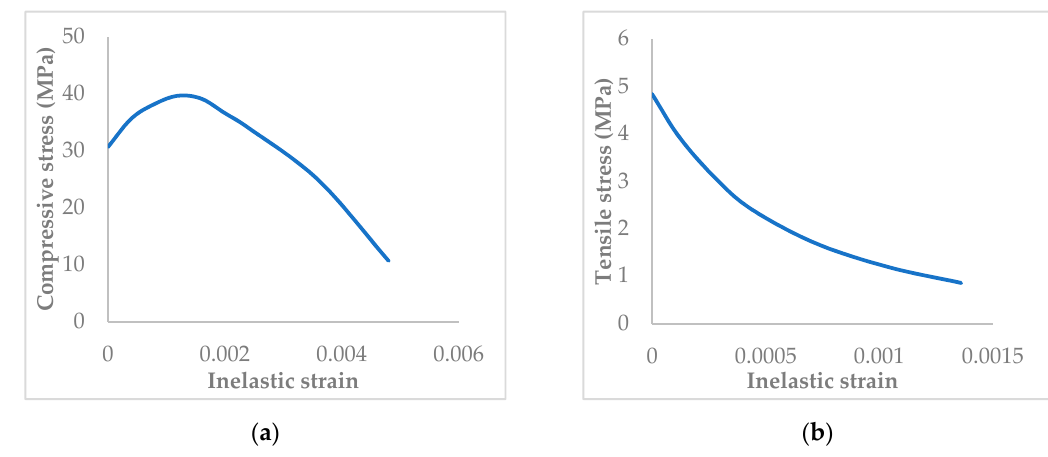
Figure 5. ( a ) Inelastic compressive and ( b ) tensile behaviors of the concrete used in the FE model.